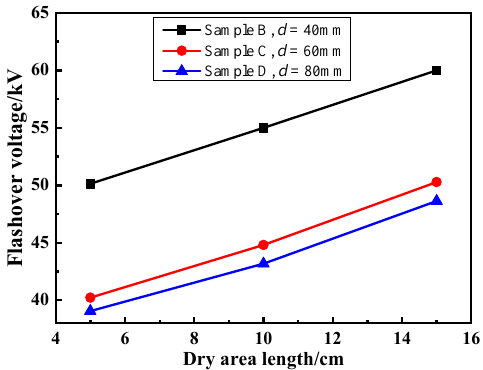
Figure 9. The relationship between flashover voltage and dry zone length of samples with different leakage lengths.